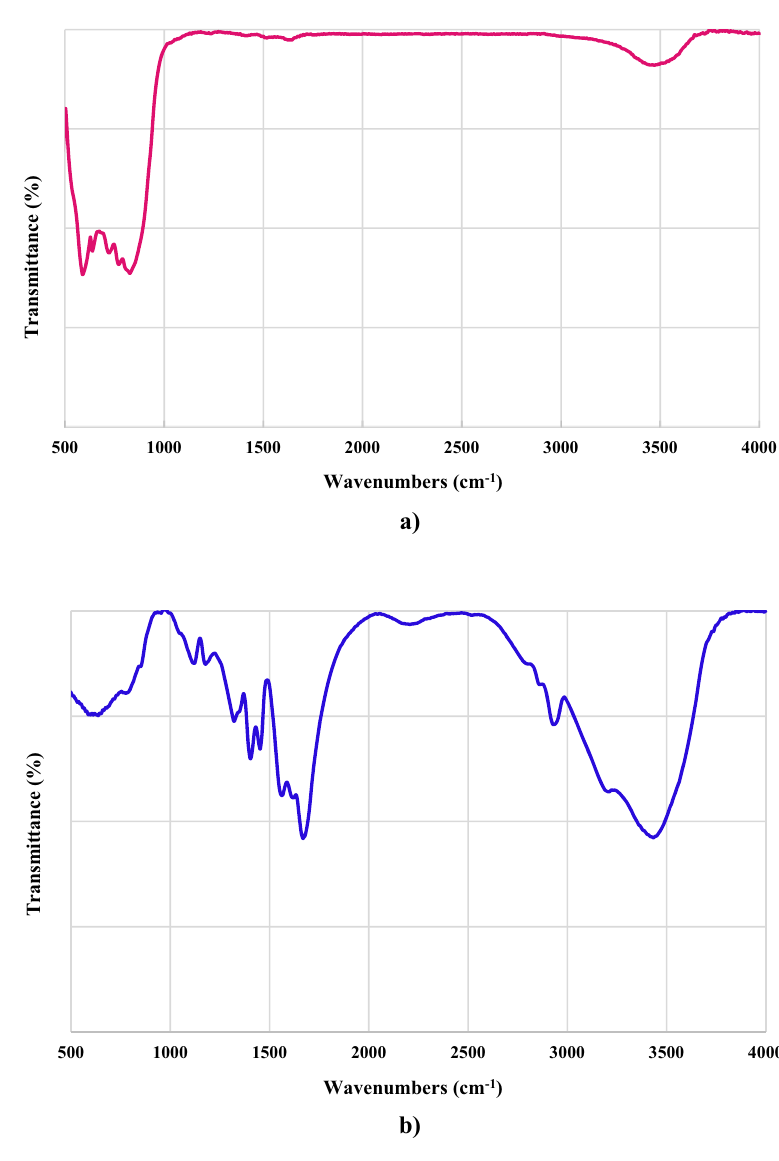
Figure 2: FTIR spectra for: ( a ) pure Al 2 O 3 NPs and ( b ) HPAM ( 0.26 wt% ) and Al 2 O 3 NPs ( 0.1 wt% )